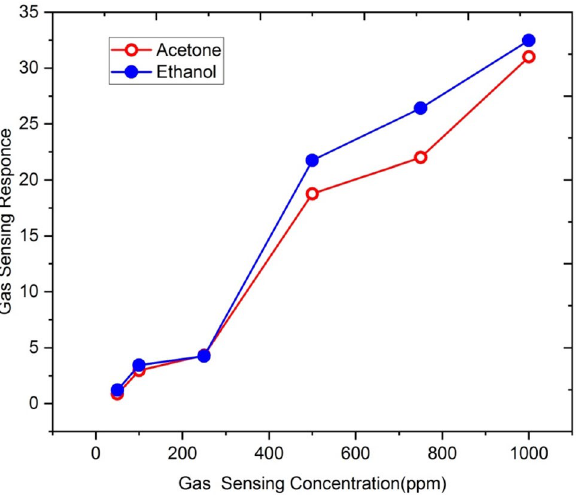
Figure 11. Sensing response of 5at% Ga-doped ZnO thin film (Ag 9+ ion irradiated with 5 × 10 13 ion/cm 2 fluence) for ethanol and aceton (250 ppm concentration) at 500 °C operating temperature.